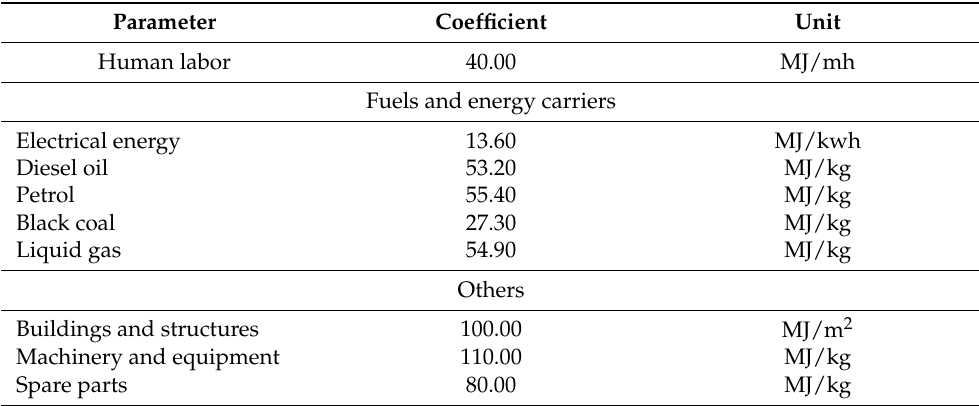
Table 3. Selected values of cumulative energy intensities assumed for calculations according to the research methodology and